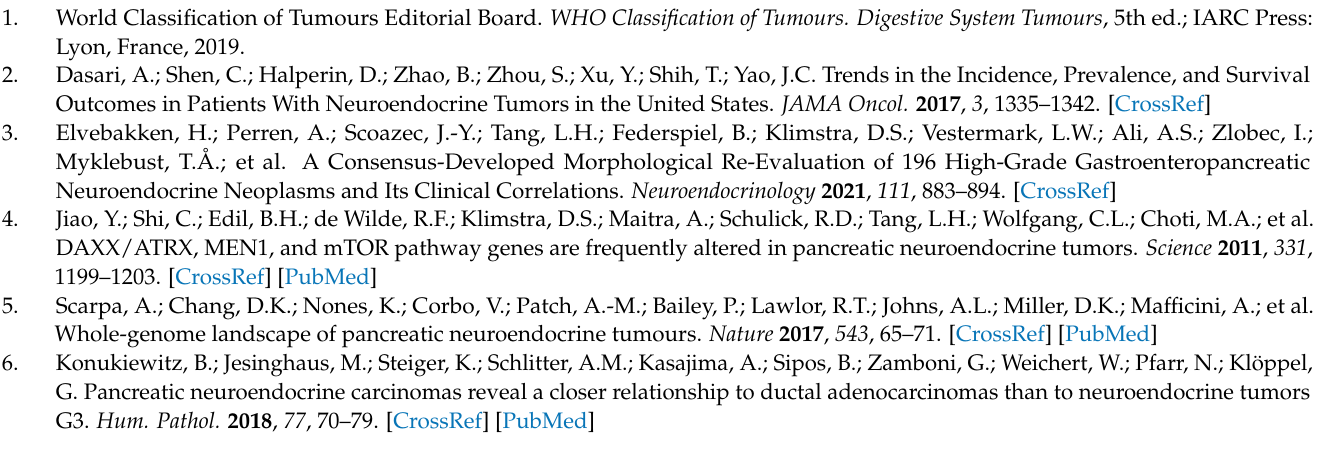
death. Figure S3. (A) Example of tumor classification in the Rip1TAG2 model and Ki67 staining. (B) EZH2 and H3K27me3 expression in control and GSK126-treated animals. While EZH2 expression did not change between treated and control mice, the H3K27me3 level significantly decreased after GSK126 treatment. (C) Quantification based on QuPath scoring of EZH2, H3K27me3, H3K36me3, and Ki67 across the different tumor stages in Rip1TAG2 GSK126-treated and control mice. (D) Tumor number in GSK126-treated and control mice. (E) Representative IHC for caspase-3 and Ki67 in treated and control mice. Figure S4. EZH2 immunohistochemistry on the original tumor tissue from which PanNETs tumoroids were